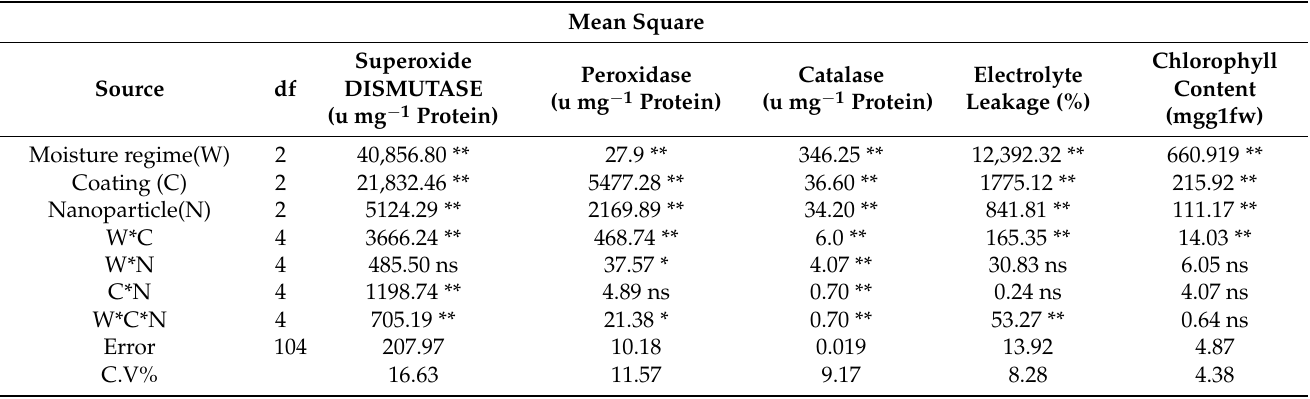
Table 8. Analysis of variance for superoxide dismutase, peroxidase, catalase, electrolyte leakage, and chlorophyll content as affected by moisture regime, coating, and nanoparticle.